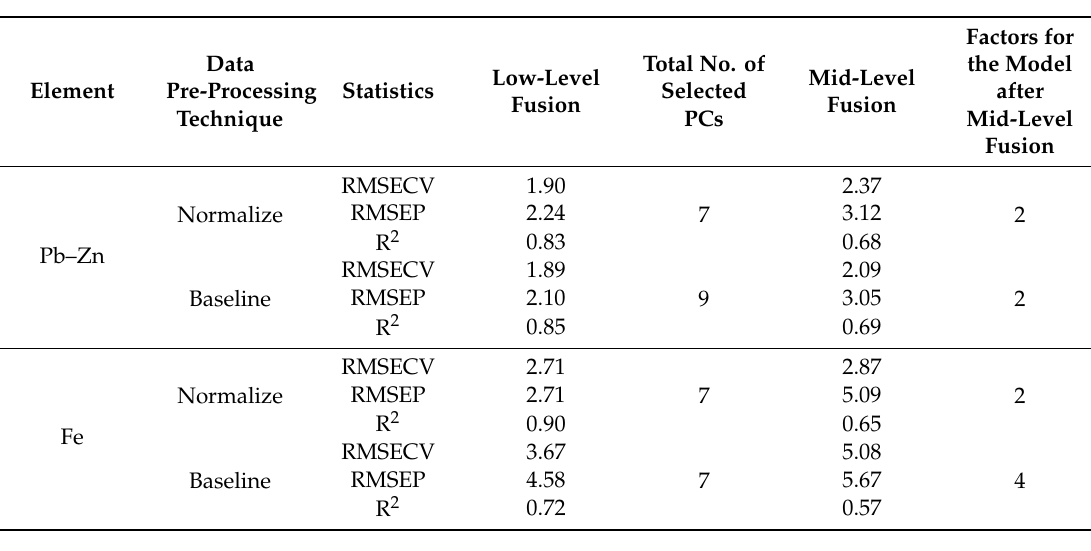
Table 5. Summary of the low-level and mid-level data fusion model performance in terms of prediction accuracy of Fe and the combined Pb–Zn concentration. The total number of selected principal components (PCs) shows the number of selected PCs from the principal component analysis (PCA) models of the MWIR and LWIR